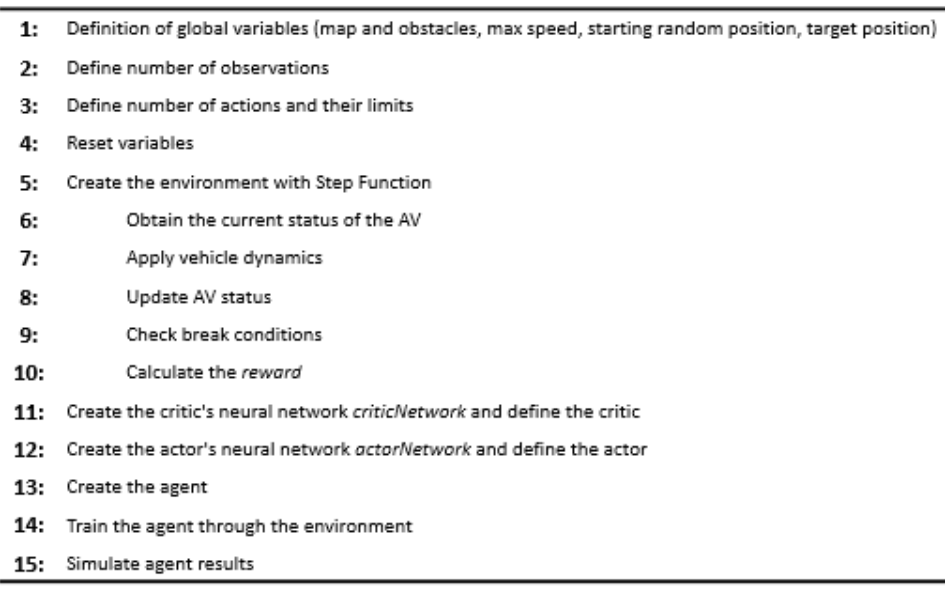
Figure 3. Agent procurement process pseudocode.